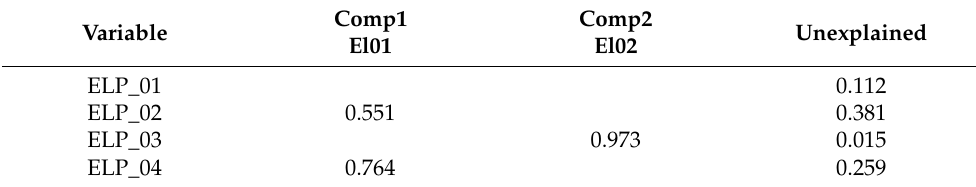
Table 20. Rotated component matrix—e-learning